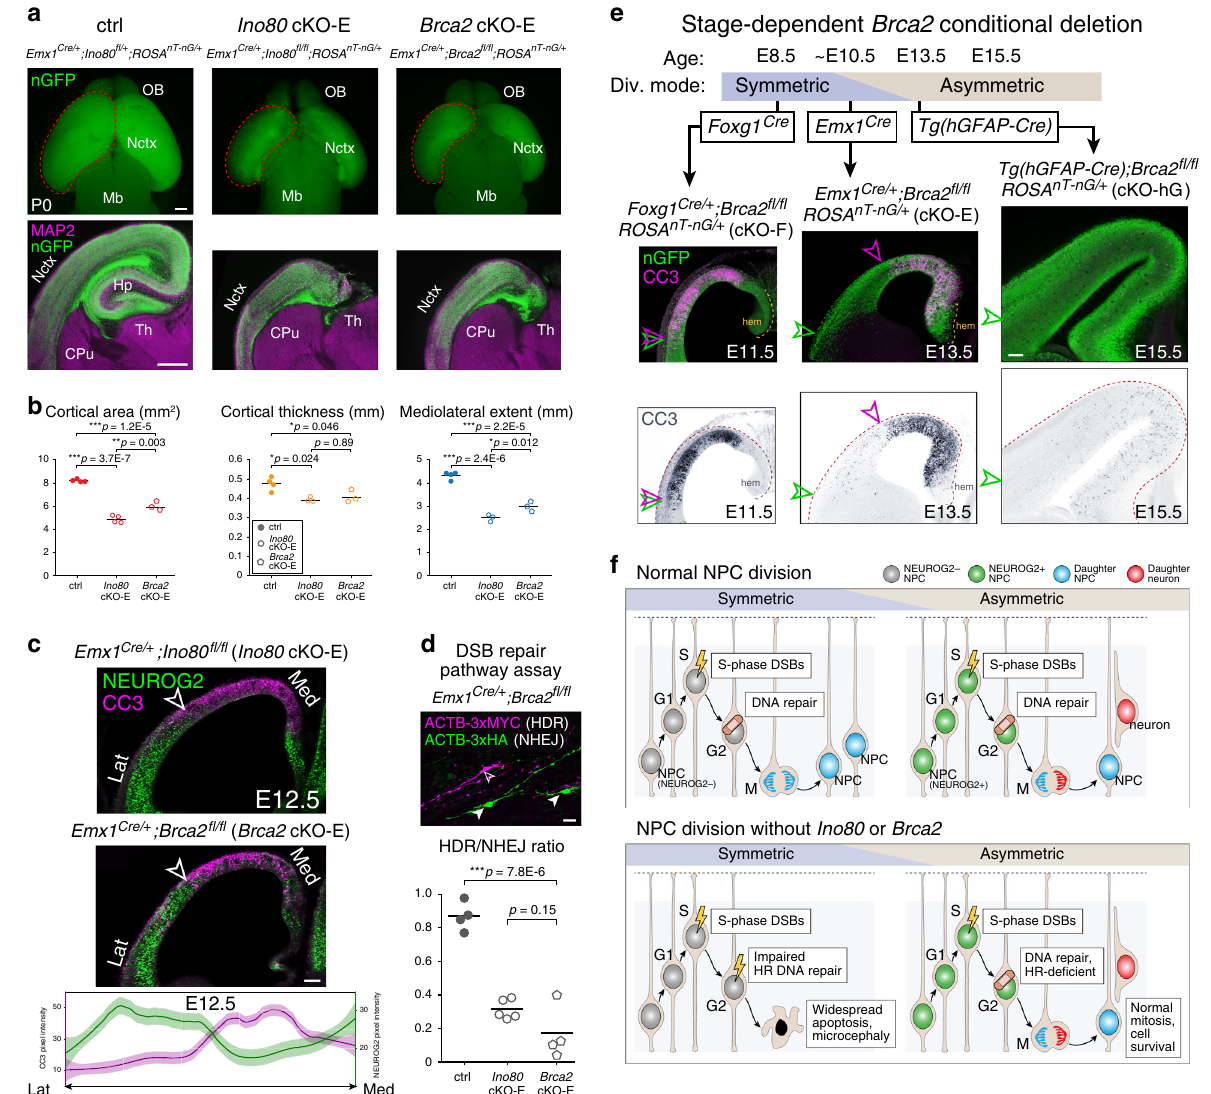
Fig. 8 A selective requirement for Ino80 -mediated HR in symmetric NPC – NPC divisions. a P0 whole-mount brains and immunostaining for MAP2 (magenta) and nGFP (green). Emx1 Cre -mediated deletion of HR gene Brca2 ( Brca2 cKO-E) led to microcephaly and hippocampal hypoplasia reminiscent of Ino80 cKO-E ( n = 3 animals). b The signi fi cant reductions in Ino80 cKO-E cortical area (red), thickness (yellow), and mediolateral extent (blue) were each phenocopied in Brca2 cKO-E (data are mean, one-way ANOVA with Tukey ’ s post hoc test, ctrl: n = 4, Ino80 cKO-E cortical area: n = 4, thickness, mediolateral extent: n = 3, Brca2 cKO-E: n = 3 animals). c Complementary gradients of asymmetric neurogenic divisions (NEUROG2, green) and apoptosis (CC3, magenta) in Brca2 cKO-E E12.5 cortex similar to those found in Ino80 cKO-E (data are LOESS curve ± 99% con fi dence interval, n = 3 animals). d In vivo DSB repair pathway assay revealed signi fi cant decrease in HDR (ACTB-3xMYC, magenta) relative to NHEJ (ACTB-3xHA, green) in Brca2 cKO-E compared with ctrl (data are mean, one-way ANOVA with Tukey ’ s post hoc test, ctrl: n = 4, Ino80 cKO-E: n = 5, Brca2 cKO-E: n = 4 animals). e Foxg1 Cre deletion of Brca2 (cKO-F) during exclusively symmetric NPC – NPC divisions led to widespread CC3 (magenta in overlay, blue in monochrome) throughout the mediolateral axis of E11.5 cortex. The lateral extent of apoptosis (magenta arrowhead) reached the lateral extent of neocortex (green arrowhead). Emx1 Cre deletion of Brca2 (cKO-E) near the onset of transition between symmetric and asymmetric divisions led to robust apoptosis in medial, but not lateral, neocortex. Tg (hGFAP-Cre) deletion of Brca2 (cKO-hG) after most NPCs had transitioned to asymmetric neurogenic division did not lead to widespread increase in apoptosis. These Cre-by-Cre phenotypes were reminiscent of those found in Ino80 cKOs ( n = 3 animals). f During corticogenesis, synthesis-associated DSBs in dividing NPCs are repaired in S, G2, or M phase to safeguard genome integrity. Following Ino80 or Brca2 deletion from NPCs, HR was selectively disrupted. In symmetrically dividing NPCs, loss of HR led to unrepaired DSBs and apoptosis. In asymmetrically dividing NPCs, Ino80 or Brca2 deletion did not give rise to unrepaired DSBs or apoptosis, suggesting that homology-independent DNA repair pathways were suf fi cient. Thus, distinct modes of NPC division have divergent requirements for HR DNA repair. Scale bar: 500 μ m in a ; 100 μ m in c , e ; 20 μ m in d division (Fig. 7). To systematically dissect the consequences of apoptosis throughout the mediolateral extent of E11.5 cortex Brca2 deletion, we similarly used Foxg1 Cre , Emx1 Cre , and Tg (Fig. 8e), whereas Brca2 deletion by Tg( hGFAP-Cre ), after NPC ( hGFAP-Cre ). We found a remarkable Cre-by-Cre phenocopy transition to asymmetric divisions, did not. This striking Cre-by- between Ino80 and Brca2 cKOs. Brca2 deletion by Foxg1 Cre Cre phenocopy between Ino80 and Brca2 , a bona fi de HR gene, during exclusively symmetric divisions led to widespread provided strong support that Ino80 mediates DNA repair by HR